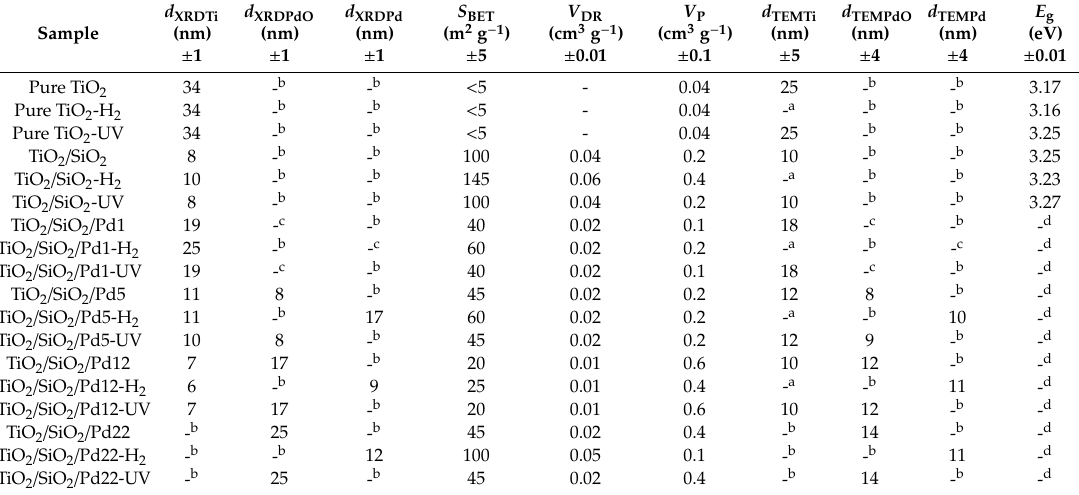
Table 2. Samples’ crystalline, textural and optical